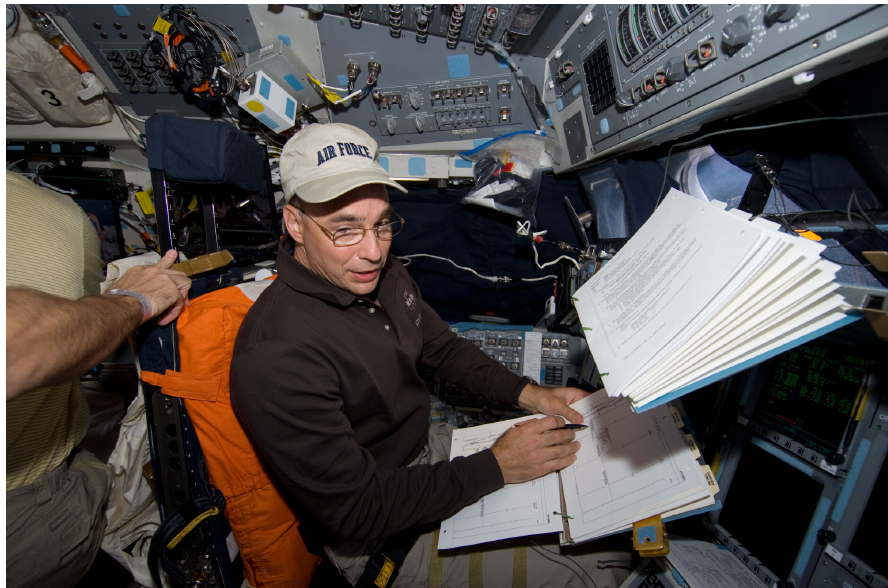
Figure 1. Astronaut Lee Archambault, STS-119 commander, looks over checklists from the comman- der’s station on the flight deck of Space Shuttle Discovery. Courtesy